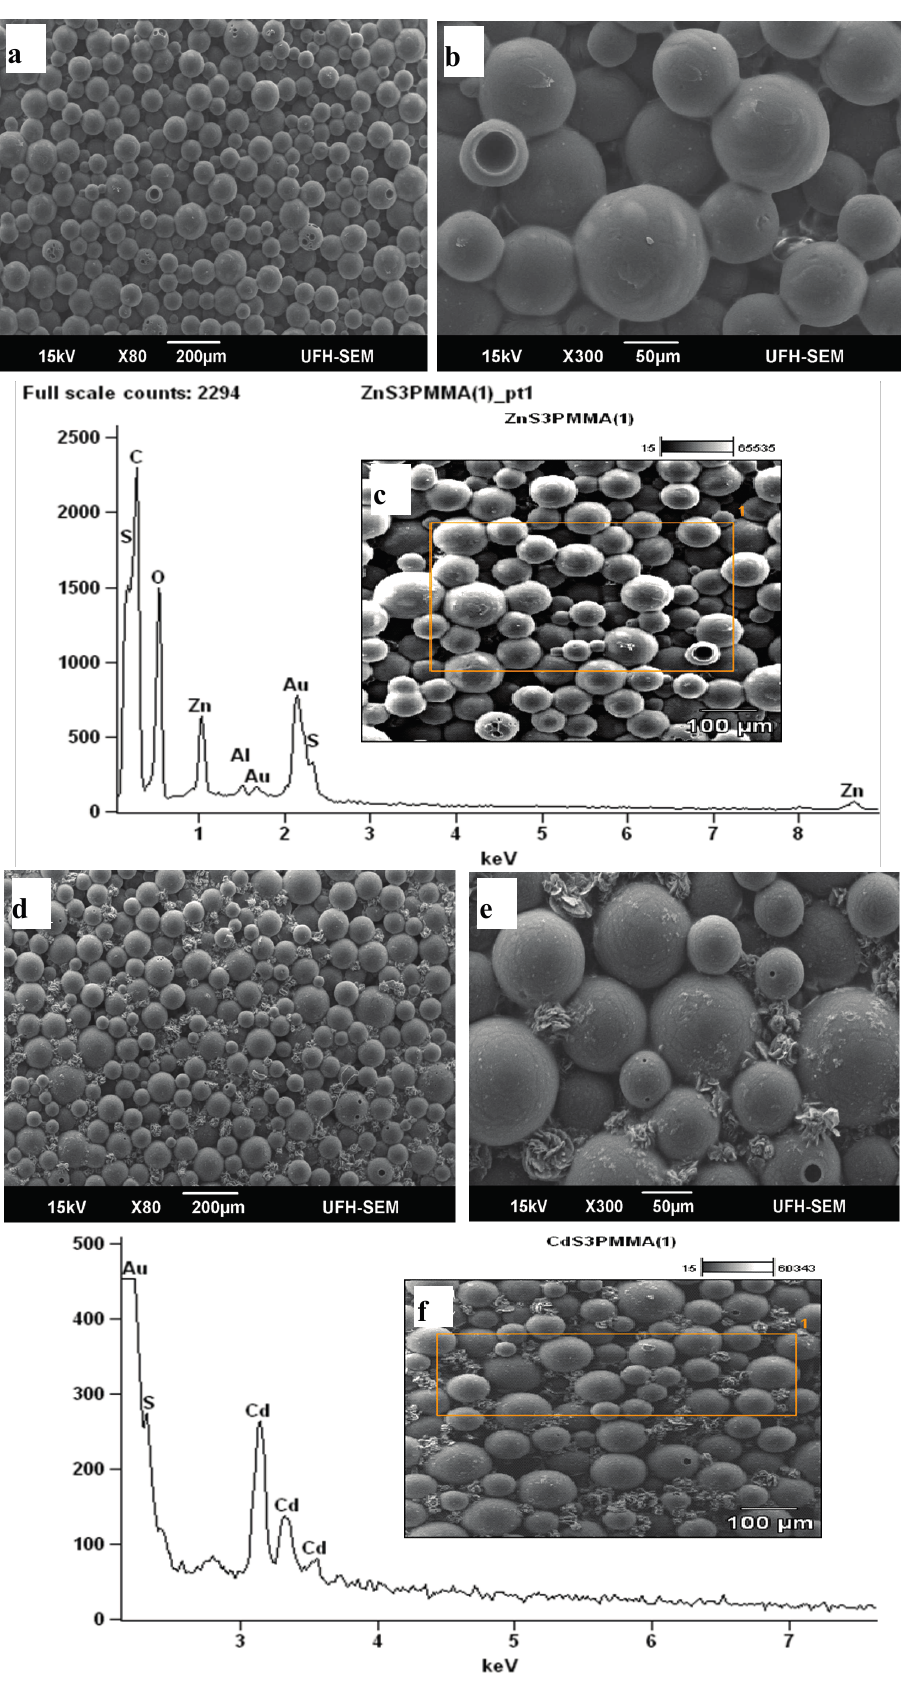
Figure 4. SEM images and EDX for ZnS/PMMA ( a , b , c ); CdS/PMMA ( d , e , f ) and HgS/PMMA ( g , h , i )